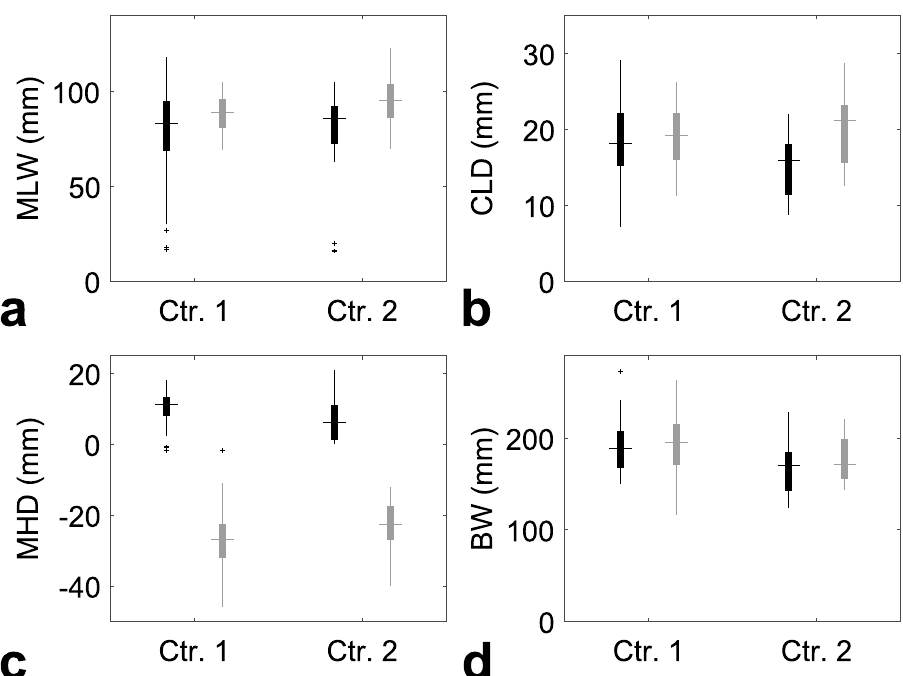
Figure 3. Individual variability of anatomic features that were found most influential on lung doses. Boxplots indicate the distribution of these measures among respective patient groups, separately for centres 1 and 2 and also for patients with left- and right-sided breast cancer (in black and grey). The mid line shows the median of the group, the box covers its 25th to 75th percentile, the whiskers denote the range of values not considered outliers, and the points show these outliers.